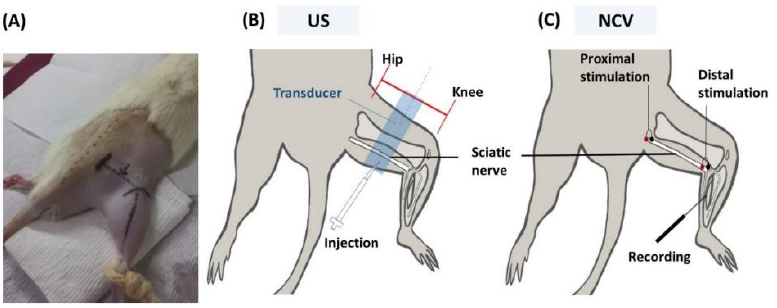
Figure 7. Positioning ( A ) and localization of sciatic nerve in US-guided injection ( B ) and NCV exam ( C ). Blue rectangle: placement of US probe. ( C ). Blue rectangle: placement of US